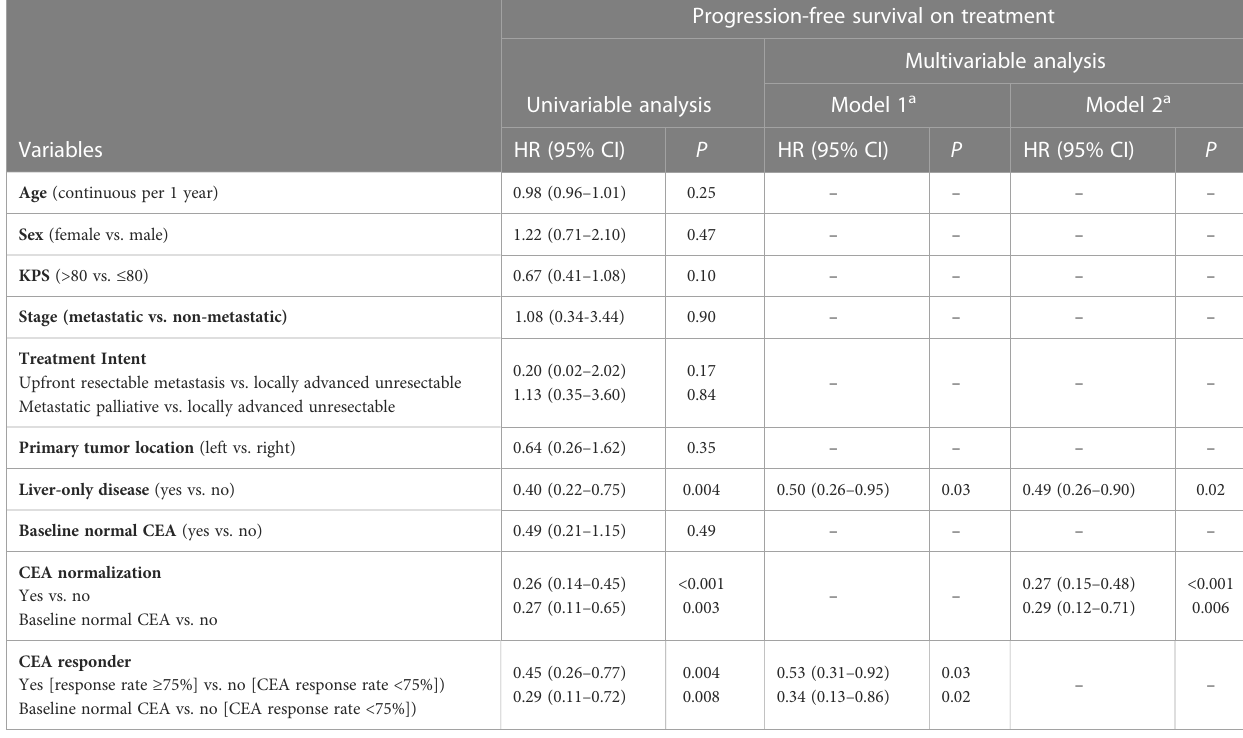
TABLE 3 Univariable and multivariable analyses of prognostic factors for progression-free survival on treatment, Hong Kong, 2019 – 2021 (N = 106).